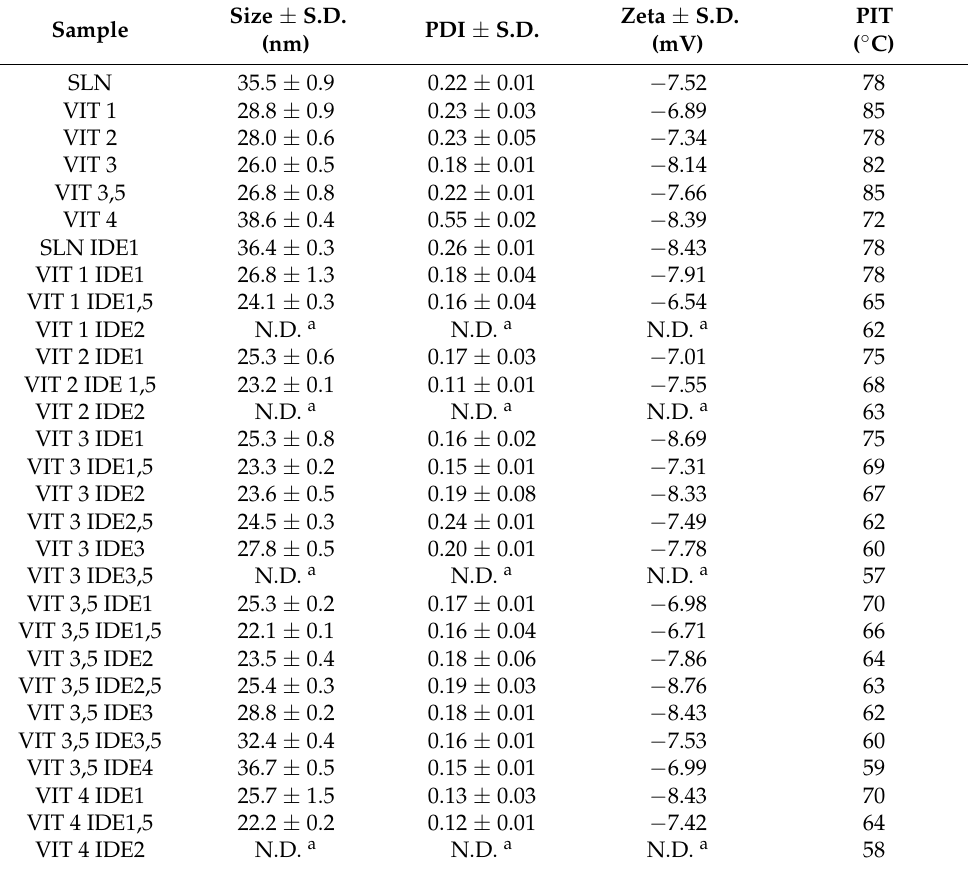
Table 2. Mean size, polydispersity index (PDI), ζ -potential (Zeta) and phase inversion temperature (PIT) of unloaded and IDE-loaded lipid nanoparticles.